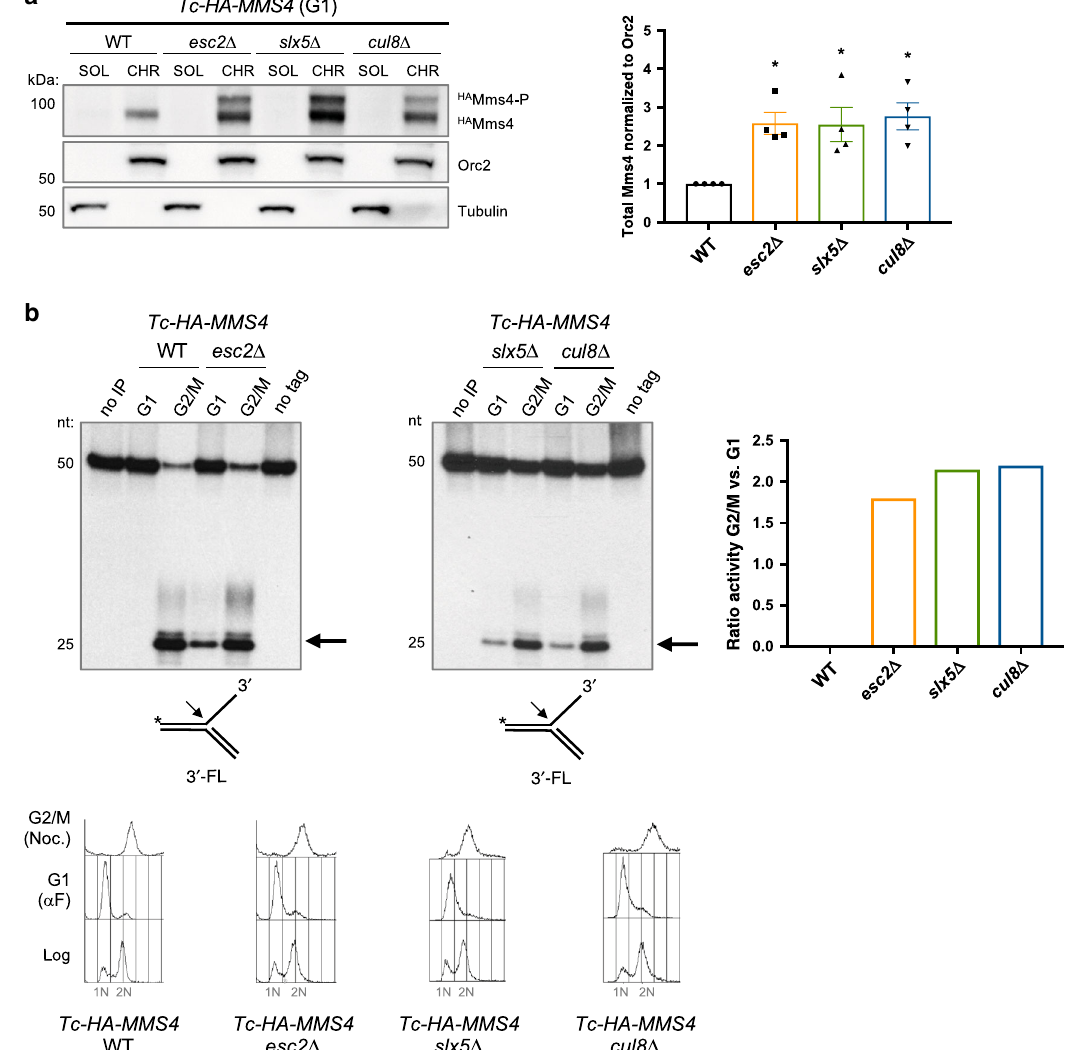
Fig. 4 Impaired turnover of phosphorylated Mms4 leads to increased chromatin association and abnormal Mus81 – Mms4 nuclease activity in the next G1 phase. a Chromatin binding of Mms4 in G1 phase in WT, esc2 Δ , slx5 Δ , and cul8 Δ cells. Tc-HA-Mms4 cells of the indicated background were synchronized in G1 phase with α -factor and samples were processed to obtain soluble (SOL) and chromatin (CHR) fractions. Both fractions were analyzed by western blot, using an anti-HA antibody. Orc2 served as a chromatin marker and Tubulin as a control for the soluble fraction. The graph represents the quanti fi cation of n = 4 independent experiments. Mms4 protein levels of esc2 Δ , slx5 Δ , and cul8 Δ were normalized to Orc2 levels and are shown relative to WT samples. The bars represent the mean values ± SEM. P values were obtained by using a two-tailed unpaired Student ’ s t test with Welch ’ s correction, the asterisk indicates * P < 0.05. Compared to WT, P value for esc2 Δ = 0.012; slx5 Δ = 0.041; cul8 Δ = 0.016. b Nuclease activity assay of Mms4. Extracts were prepared from Tc-HA-Mms4 WT, esc2 Δ , slx5 Δ , and cul8 Δ cells synchronized in G1 with α -factor or in G2/M with Nocodazole. Mms4 was immunoaf fi nity puri fi ed from the extracts, and the nuclease activity was assessed by the resolution of a 32 P-labeled substrate (3 ′ FL = 3 ′ fl ap). The arrow indicates the labeled product resulting from the nucleolytic cleavage of the substrate. As controls, the nuclease assay was either performed with immunoprecipitated extracts from untagged cells (no tag) synchronized in G2/M or the assay was performed in the absence of extract (no IP). Nuclease activity was quanti fi ed as the percentage of the cleaved fragment with respect to the total labeled substrate for WT, esc2 Δ , slx5 Δ , and cul8 Δ in G1 and G2/ M and then deriving the ratio of activity in G2/M versus G1. Cell synchronization was con fi rmed by fl ow cytometric analysis. 1N and 2N in gray indicate G1 and G2/M phases, respectively. nt stands for nucleotide. Source data are provided as a Source data fi